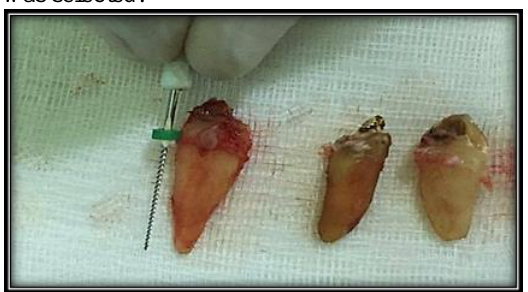
Figure 3: Measurement of extracted root length by endodontic file.